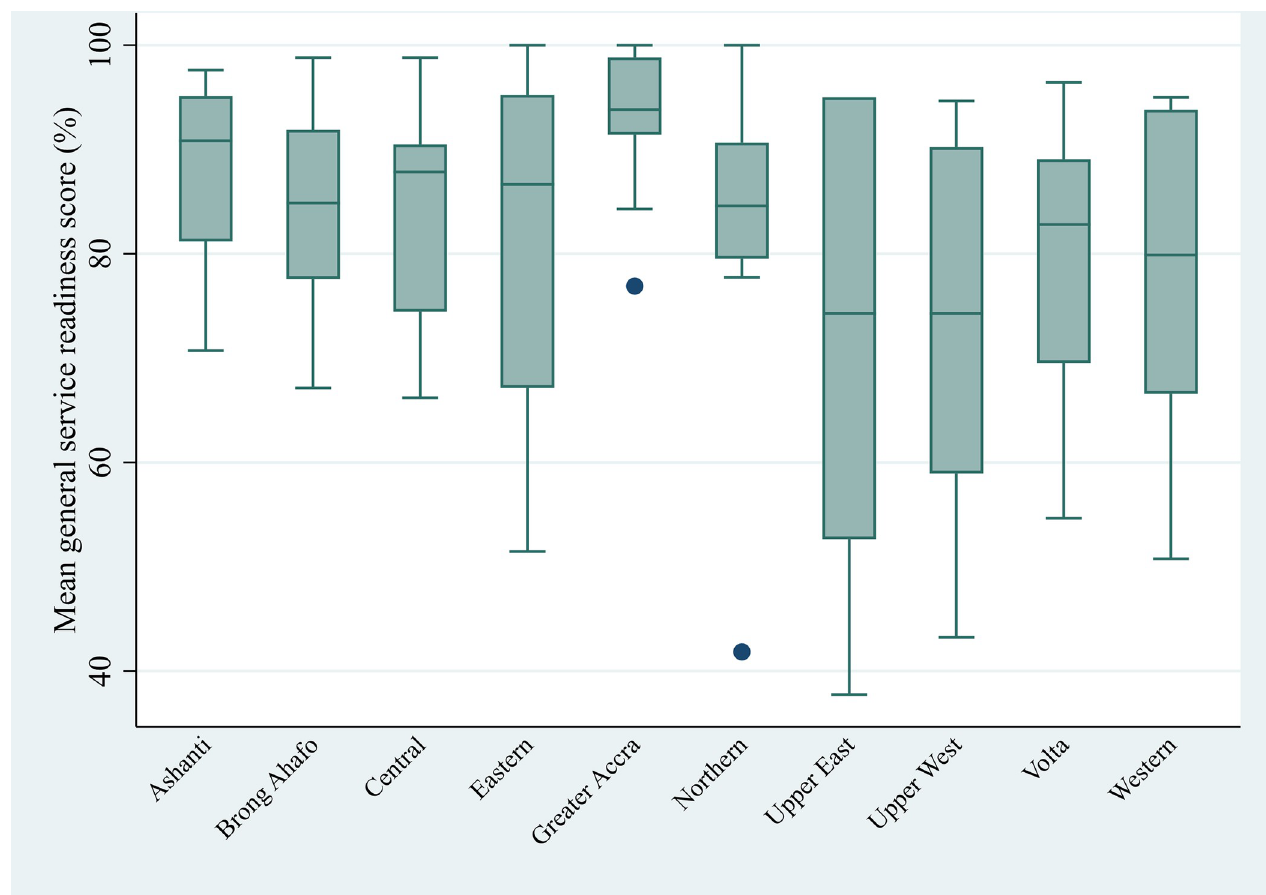
Fig 2. Box plots of general service readiness score by